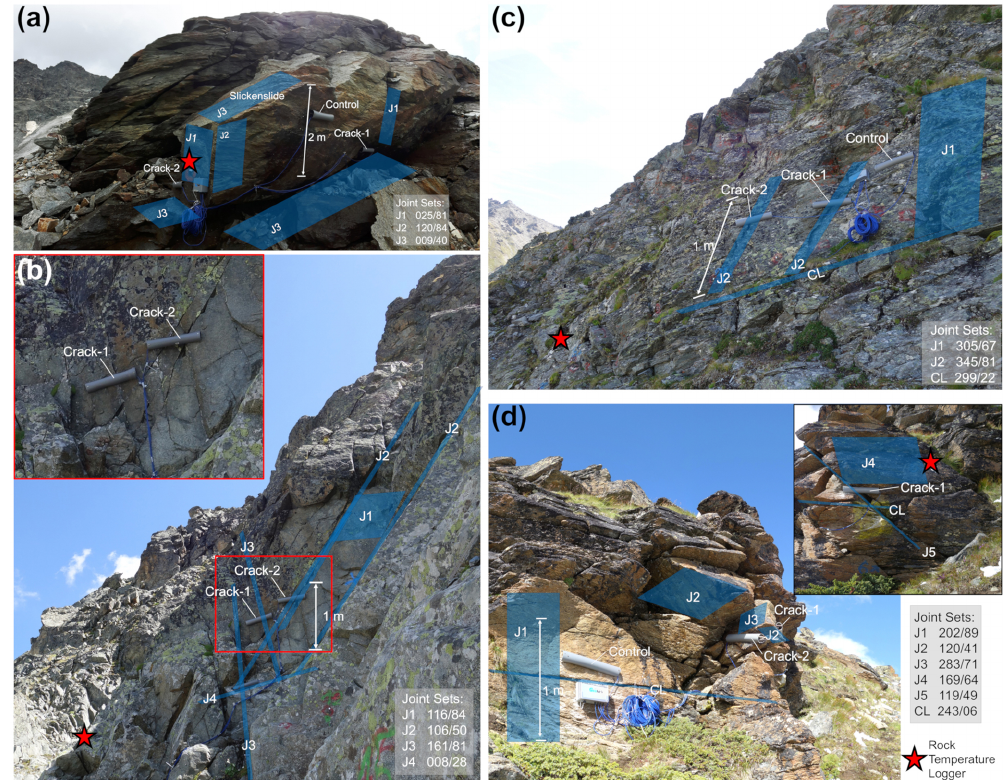
Figure 3. (a) Three crackmeters were attached to two large ( > 2m) aplite blocks at RW1 at 2935m. (b) At RW2 at 2672m, two crackmeters were installed on densely fractured amphibolite blocks. crackmeters monitor CD and RD of schistose quartz slate (c) at RW3 at 2585 and (d) at RWS at 2723m.